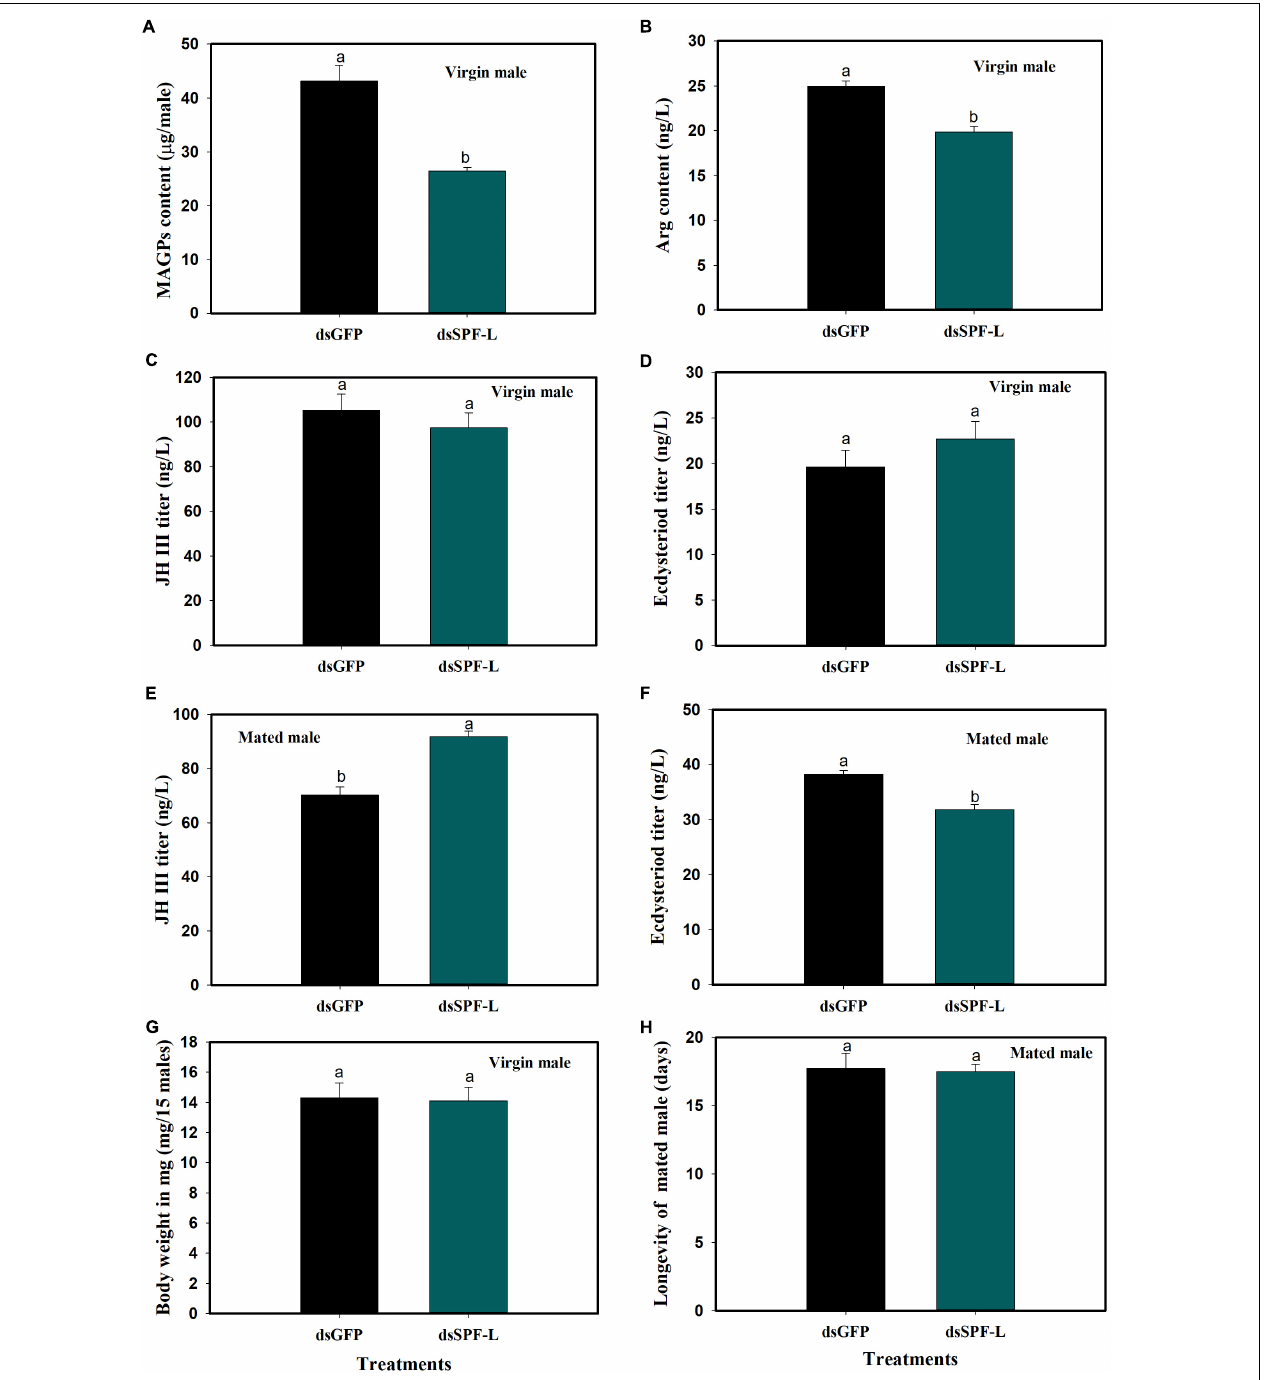
FIGURE 5 | Effects of dsSPF-L treatments on male BPH parameters. (A) The histogram bars show mean of MAGs content in dsSPF-L-treated virgin males at 2 DAE ( n = 20, N = 3 independent biological replicates). (B) The histogram bars show mean of Arg content in dsSPF-L-treatedvirgin males at 2 DAE ( n = 5, N = 3 independent biological replicates). (C) The histogram bars show mean JH III titer in dsSPF-L-treated virgin male at 2 DAE ( n = 5, N = 3 independent biological replicates). (D) The histogram bars show mean ecdysteriod titer in dsSPF-L-treated virgin male at 2 DAE ( n = 5, N = 3 independent biological replicates). (E) The histogram bars show mean JH III titer in dsSPF-L-treated mated males at 2 DAE ( n = 5, N = 3 independent biological replicates). (F) The histogram bars show mean of ecdysteroids titer in dsSPF-L-treated mated males at 2 DAE ( n = 3 independent biological replicates). (G) The histogram bars show mean body weight in dsSPF-L-treated virgin males at 2 DAE ( n = 15, N = 3 independent biological replicates). (H) The histogram bars show mean longevity in dsSPF-L-treated males ( n = 15 independent biological replicates). All error bars indicate 1 SEM. The histogram bars with different letters were significant difference at p < 0.05 (Student’s t